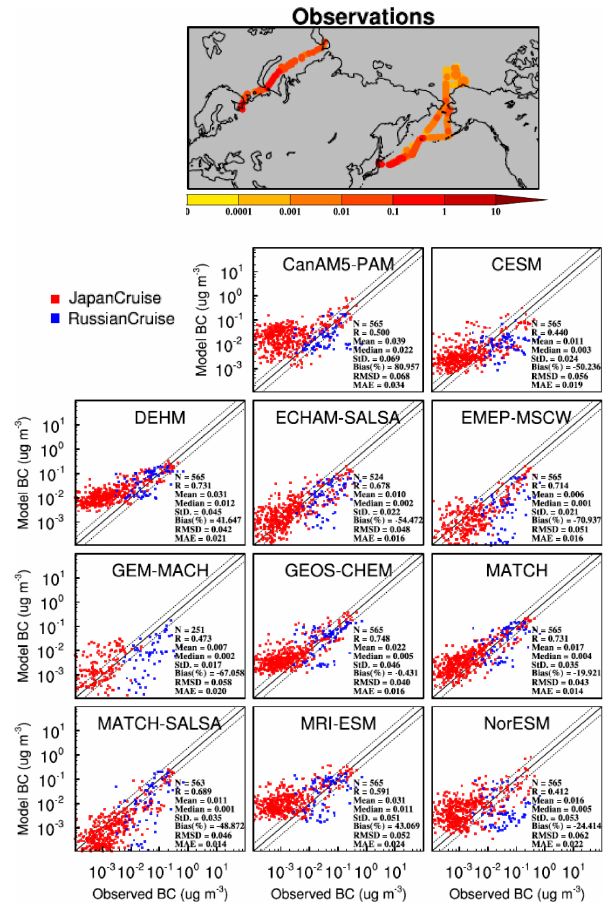
Figure 17. Observed BC concentrations (top) (µgm − 3 , top color bar) along the ship paths and (remaining panels) the modeled vs. measured 3h average BC concentrations along the ship paths. Note the logarithmic